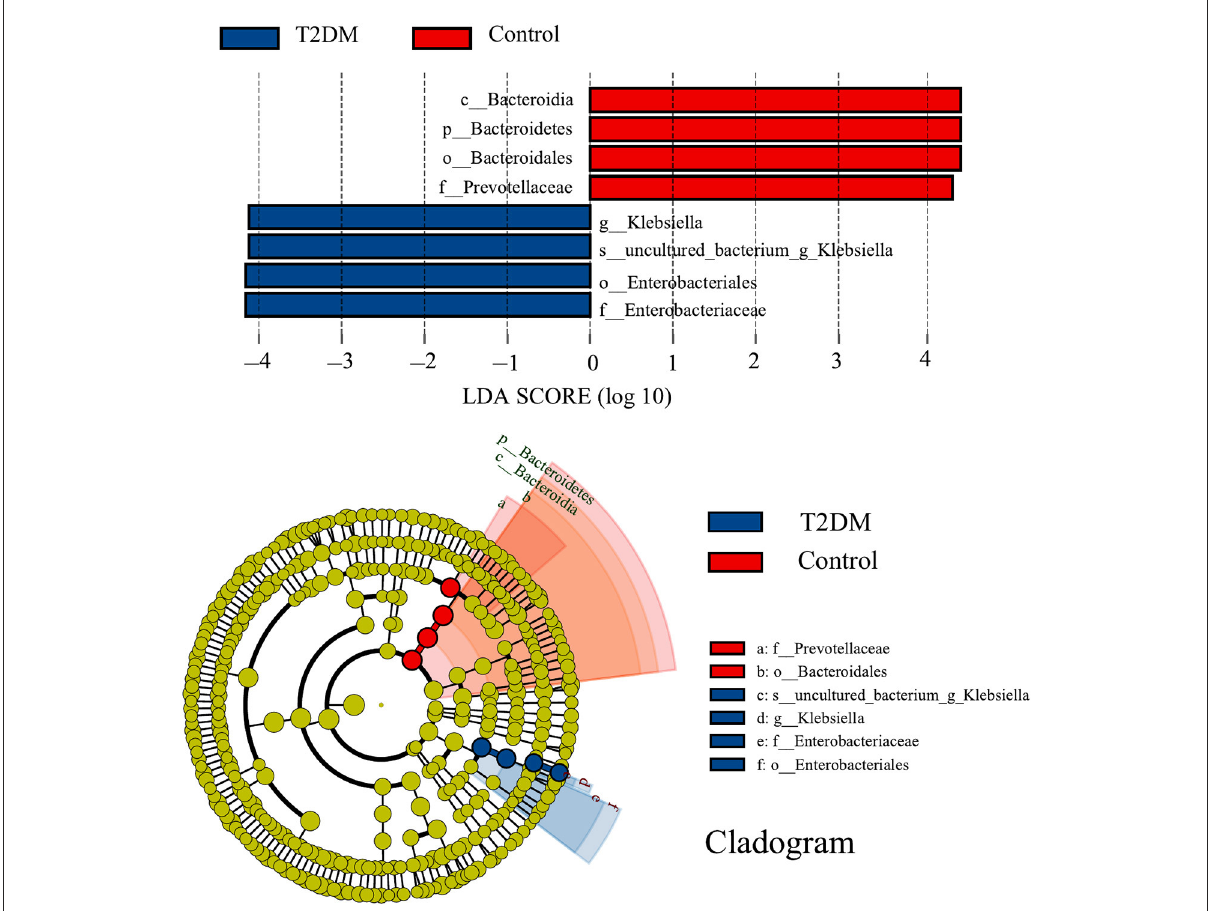
FIGURE3 LEfSe analysis and corresponding phylogenetic dendrograms between T2DM and control groups (LDA score ≥ 4). The circles radiating from inside to outside of the phylogenetic dendrograms represent taxonomic levels from phylum to species; each small circle at a different taxonomic level represents a taxon at that level, and the diameter size of the small circles is proportional to the relative abundance size; species with no significant differences are colored uniformly in